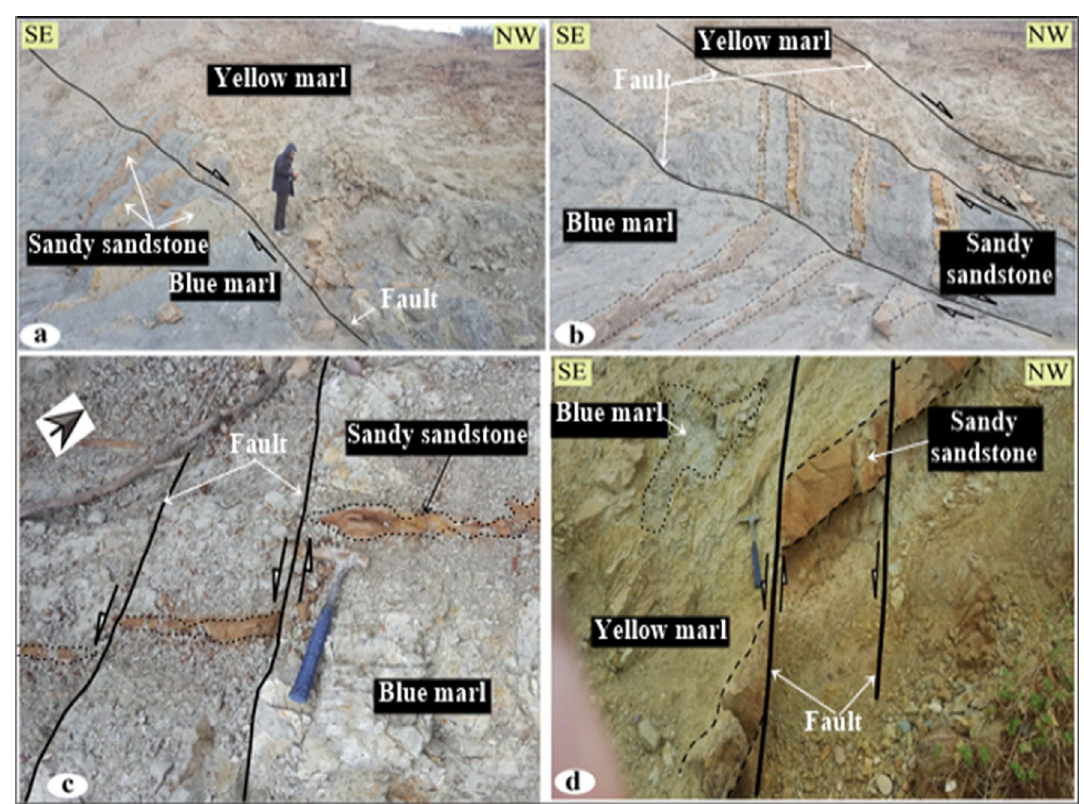
Fig. 6 Calcareous blue marl series affected by normal fault lines N70 ( d ), N105 ( c ) and N135 to N140 ( a and b